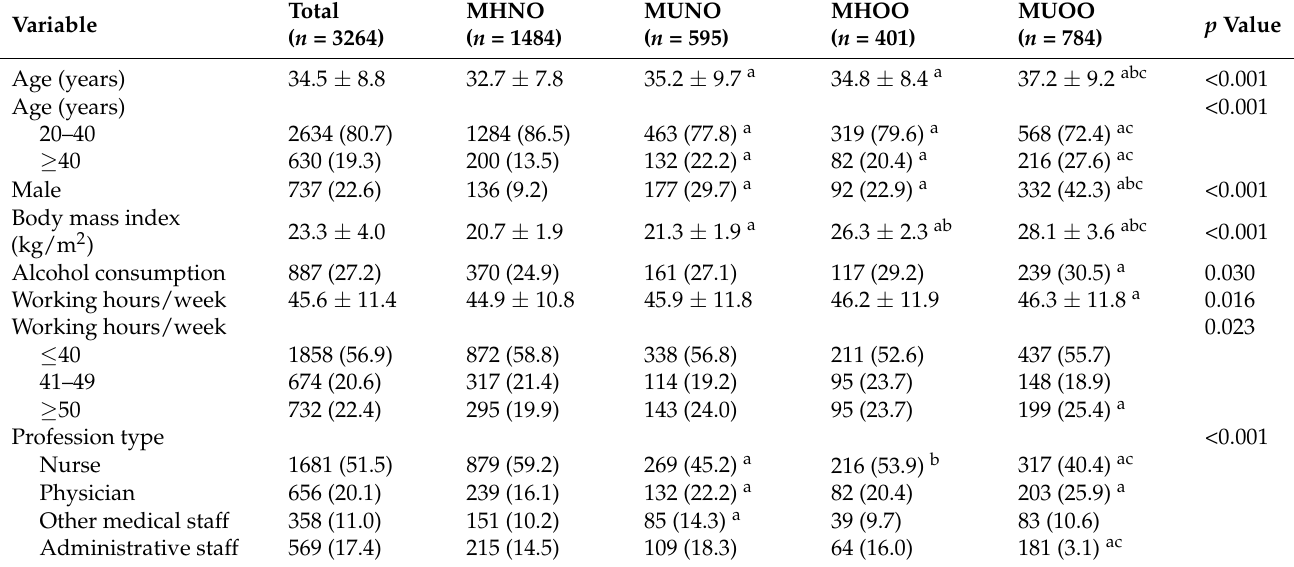
Table A1. Basic demographics of the study population according to metabolic/obesity